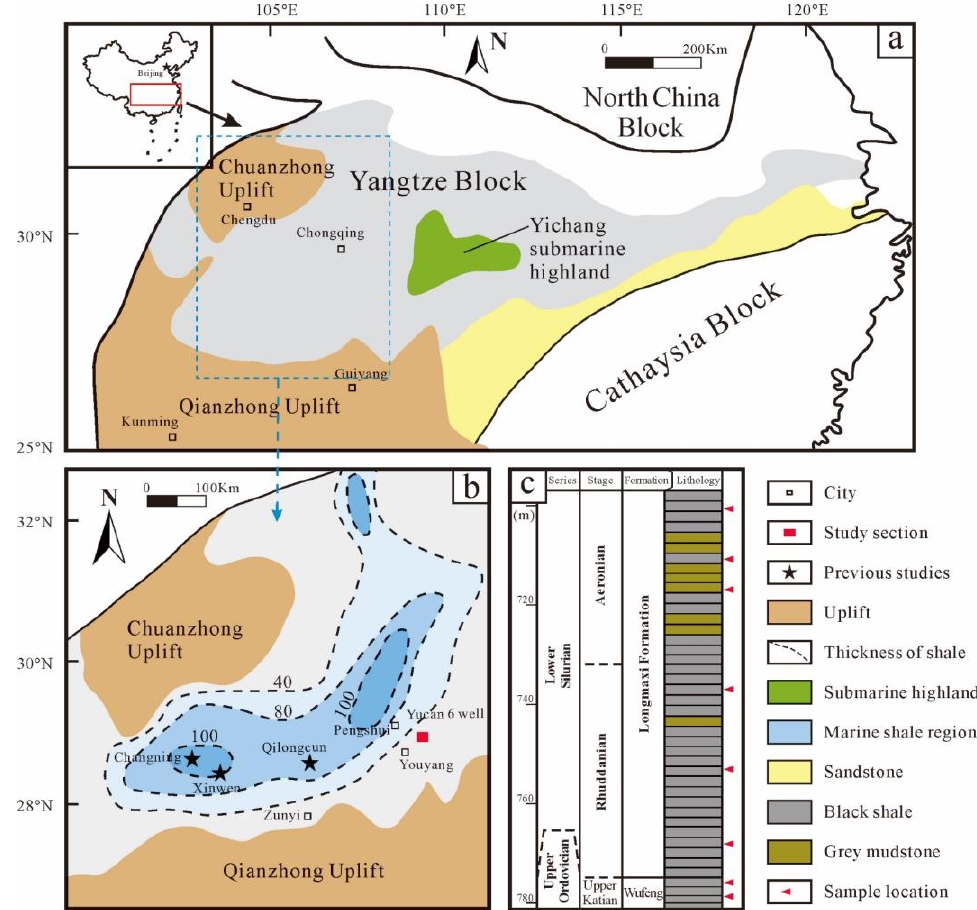
Figure 1. Ancient geographical location of the study well. ( a ) Geographical location of the Sichuan Basin in South China (adopted from [26]); ( b ) locations of Well Yucan-6 and related sections during the Early Silurian stage (adapted from [27]); ( c ) a stratigraphic column based on the Yucan-6 well.